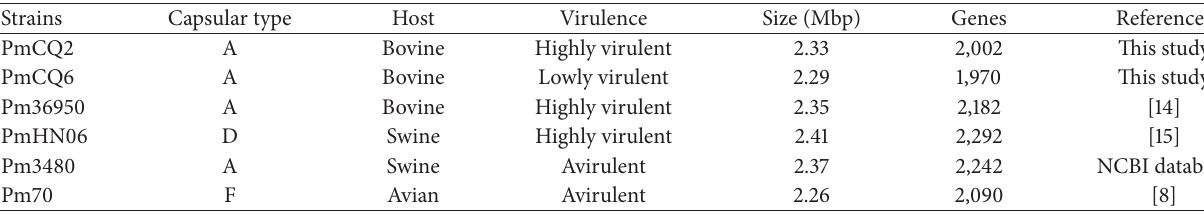
Table 1: Genome features of sequenced P. multocida